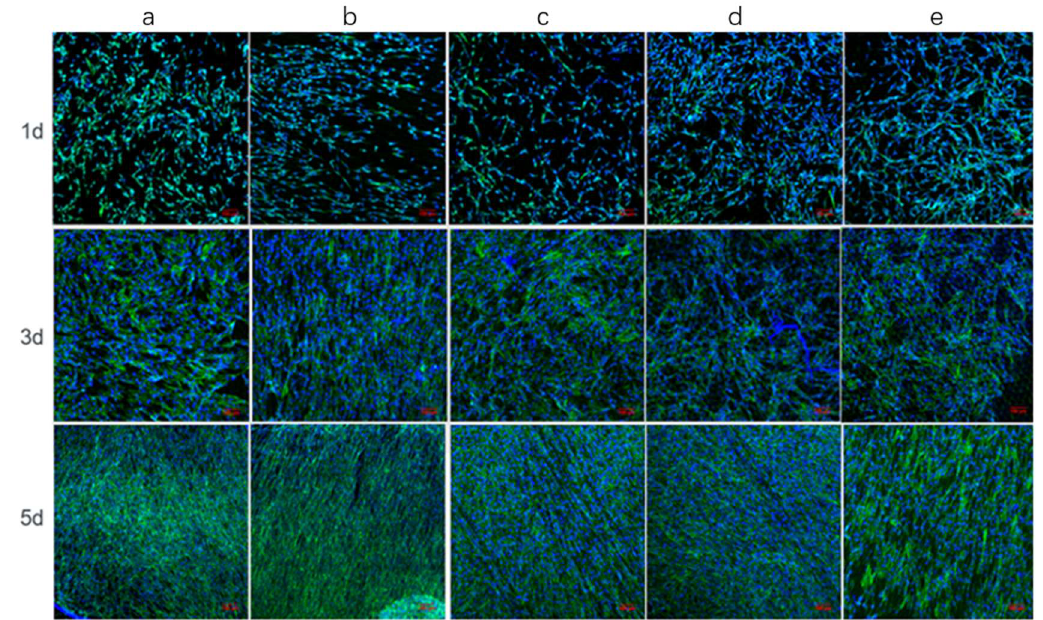
Figure 9. CLSM image of sample surface after cultured for 1, 3, and 5 days with bone marrow mesenchymal stem cells (BMSC). Notes: ( a ) groove pattern; ( b ) micro-hole pattern; ( c ) directional grain pattern; ( d ) stripe pattern ( e ) control group. Abbreviations: CLSM, confocal laser scanning microscope.